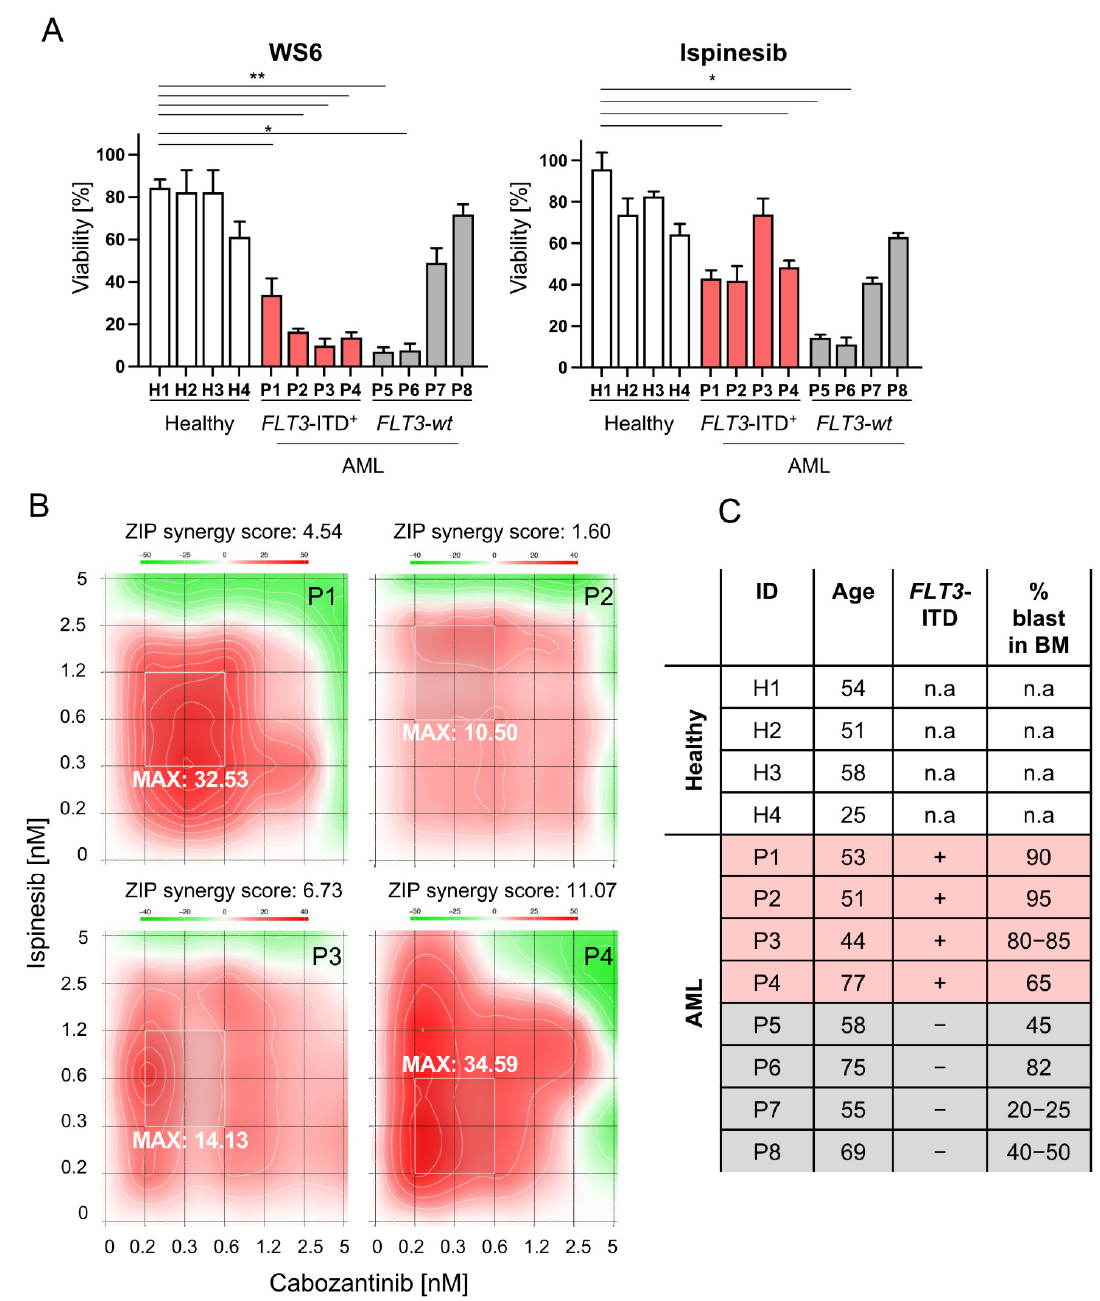
Figure 6. Combination of ispinesib and cabozantinib in FLT3 -ITD + AML patient samples displays marked drug synergy. ( A ) Effect of 1 µM WS6 or ispinesib on viability of patient bone marrow samples and healthy controls. Viability was measured after 48 h using CellTiter-Glo ® and normalized to DMSO control. * p < 0.05, ** p < 0.01. ( B ) Representative interaction landscape between cabozantinib and ispinesib in bone marrow samples from FLT3 -ITD + patients. The most synergistic area is shaded and maximum synergy score is indicated. ZIP stands for Zero interaction potency. ( C ) Overview on the cytogenetics, age and percentage of blast in bone marrow (BM) of involved patients. Next, the synergy between ispinesib and cabozantinib was validated in patient samples. We observed that the combination of these two compounds yielded an additive